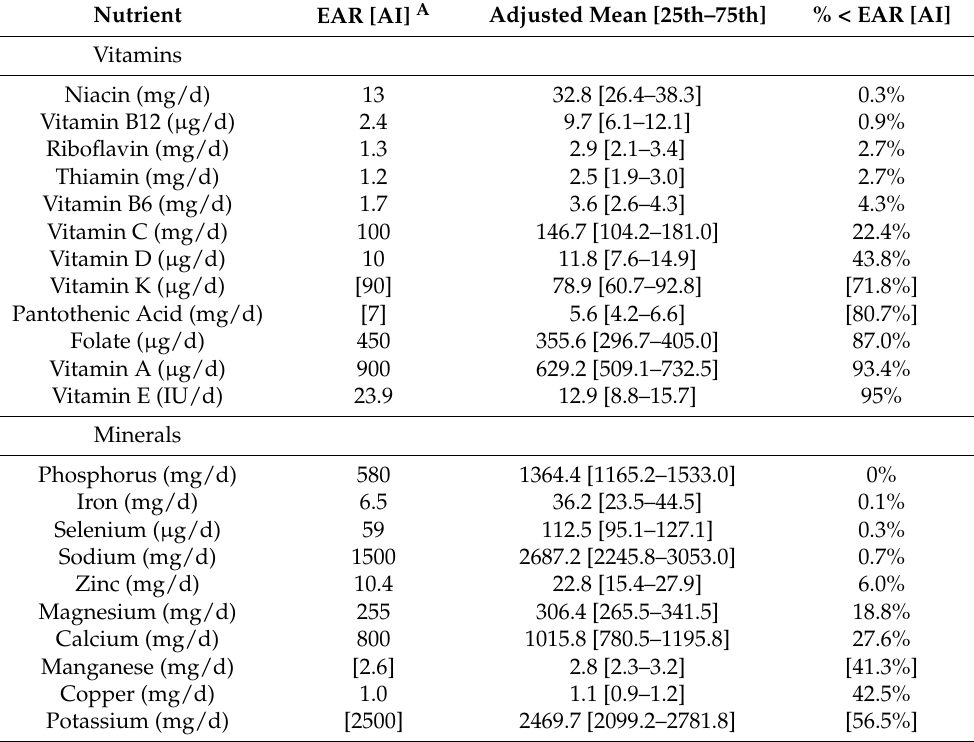
Table 1. The mean and 25th–75th percentiles of usual intake from 1 to 6 months postpartum and percent of women below the estimated average requirement (EAR) or adequate intake (AI) after adjusting for timepoint and day of the week recall was performed. Usual intake was estimated after adjusting for within-person variation using the National Cancer Institute (NCI) method. A EAR and adequate intake (AI) values come from the National Institutes of Health (NIH) for lactating women 19–50 years old, n = 188, d =